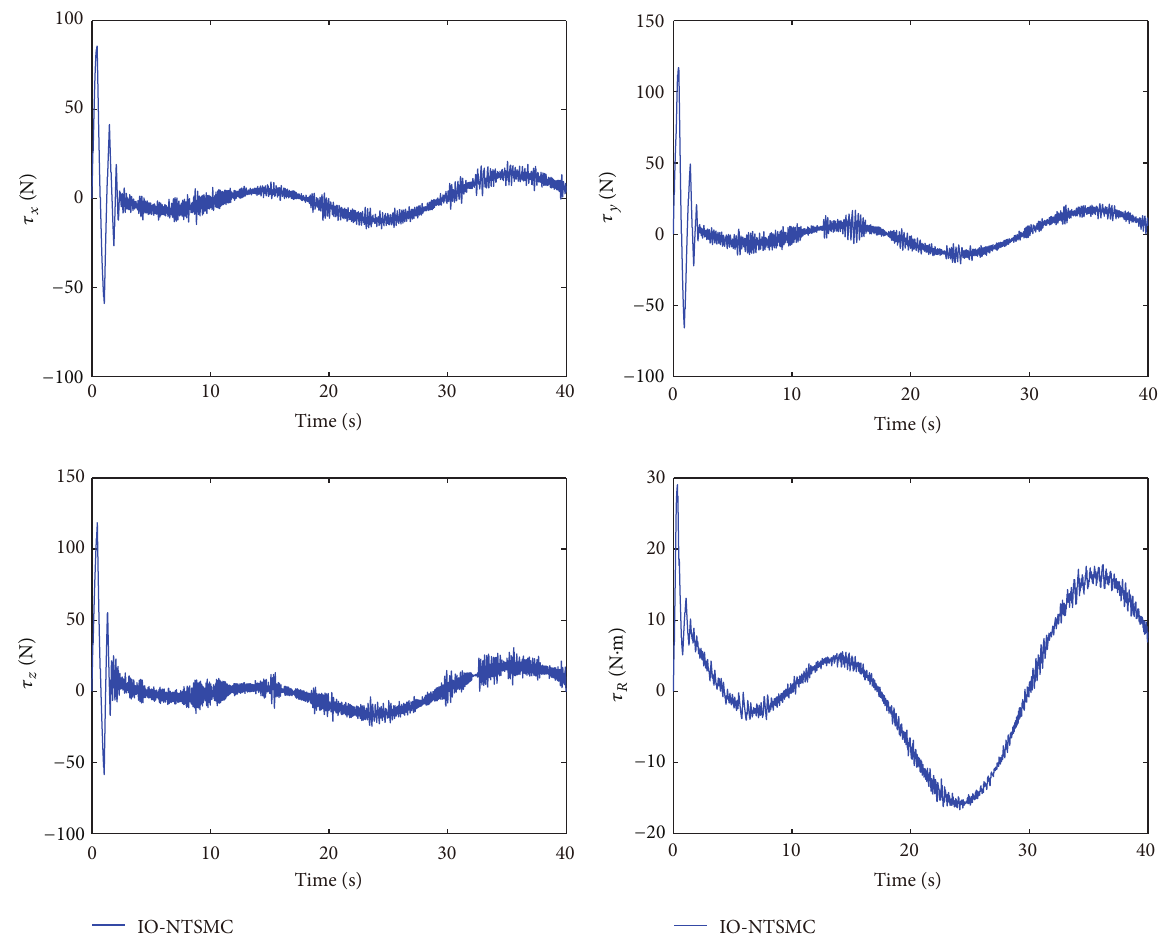
Figure 9: Control inputs of output feedback